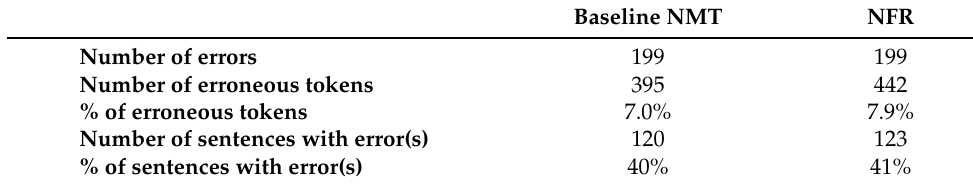
Table 10. Overview of error